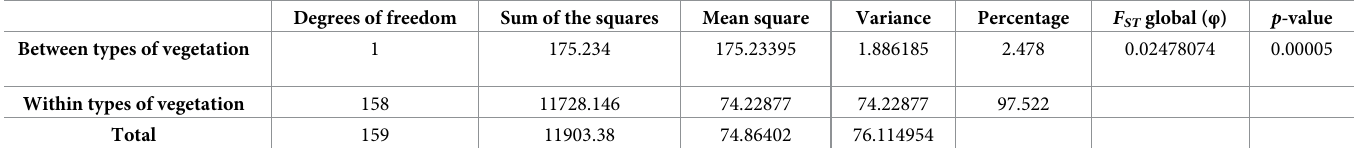
Table 5. Molecular analysis of variance (AMOVA) considering the Caatinga and Restinga for the populations of C . prunifera . Degrees of